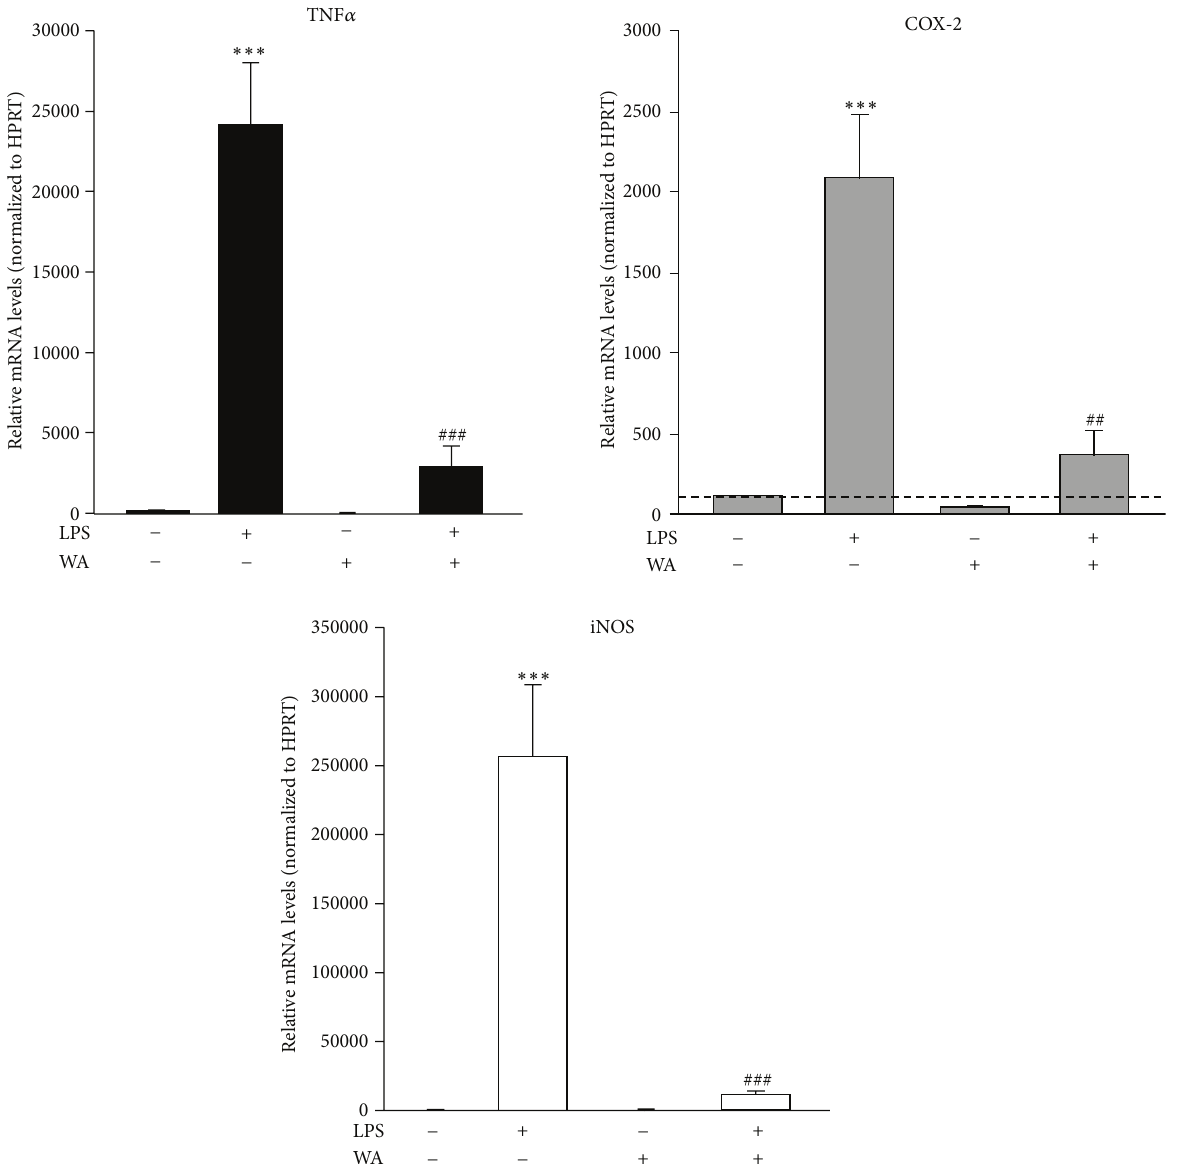
Figure 5: Effects of the post-treatment with Withaferin A on LPS-induced pro-inflammatory and stress response gene expression in primary spinal cord astrocytes. Primary astrocytes were treated with or without LPS (1 𝜇 g/mL) for 2 hours and then incubated in the absence or in the presence of 0.5 𝜇 M Withaferin A (WA) plus LPS (1 𝜇 g/mL) for additional 4 hours. Total RNA was extracted and reverse-transcribed. TNF 𝛼 , COX-2, and iNOS mRNA levels were analyzed by RT-qPCR ( 𝑛 = 2 experiments in triplicate). Values (mean ± s.e.m.) were normalized relative to HPRT and expressed as percentage of TNF 𝛼 , COX-2, or iNOS expression levels in control conditions ( ∗∗∗ 𝑝 < 0.0001 versus control, ### 𝑝 < 0.0001 and ## 𝑝 < 0.001 versus LPS; one-way ANOVA followed by Bonferroni post hoc test).